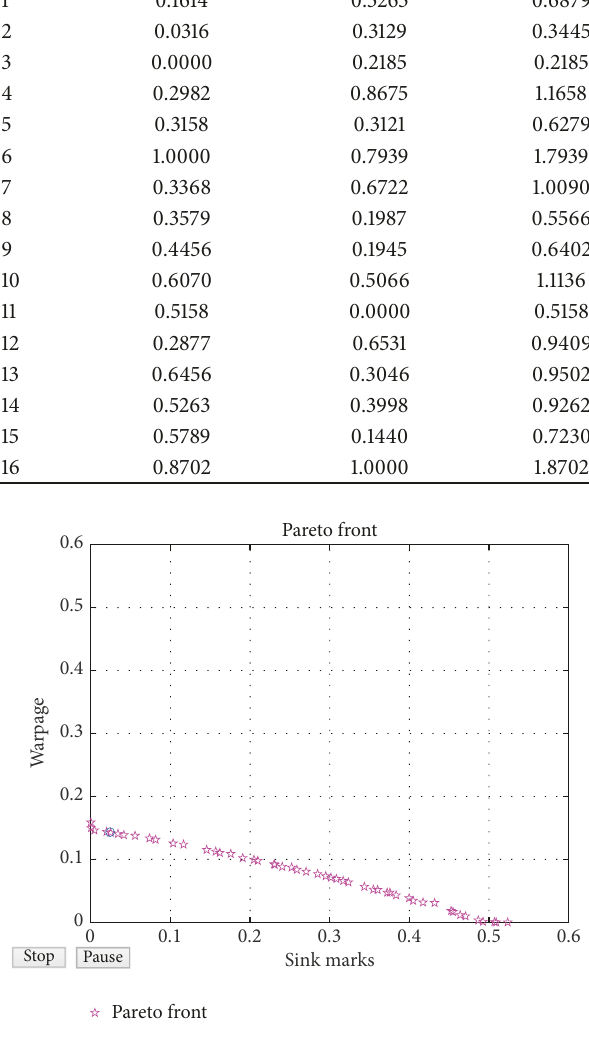
Figure 11: Solution of the